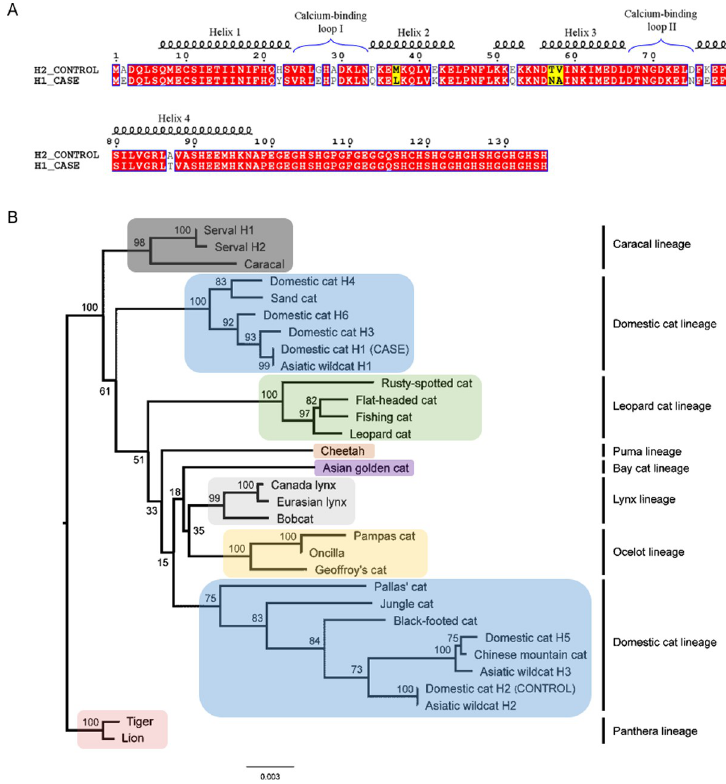
Fig 4. Highly divergent S100A9 haplotypes and comparison with wild felids. (A) Amino acid sequence alignment and secondary structure depiction of the divergent Persian cat case and control S100A9 haplotypes, created with ESPript 3.0. Conserved residues are boxed in red while similar residues are in bold text and boxed in yellow. (B) Maximum-likelihood phylogenetic tree inferred from the phased S100A9 nucleotide sequences of 22 wild felids and the domestic cat haplotypes. Bootstrap support values are given on nodes. The domestic cat lineage is split across the tree: the Persian cat case haplotype (Domestic cat H1) clusters with the sand cat near the root of the tree while the control haplotype (Domestic cat H2) is found in the expected location for the domestic cat